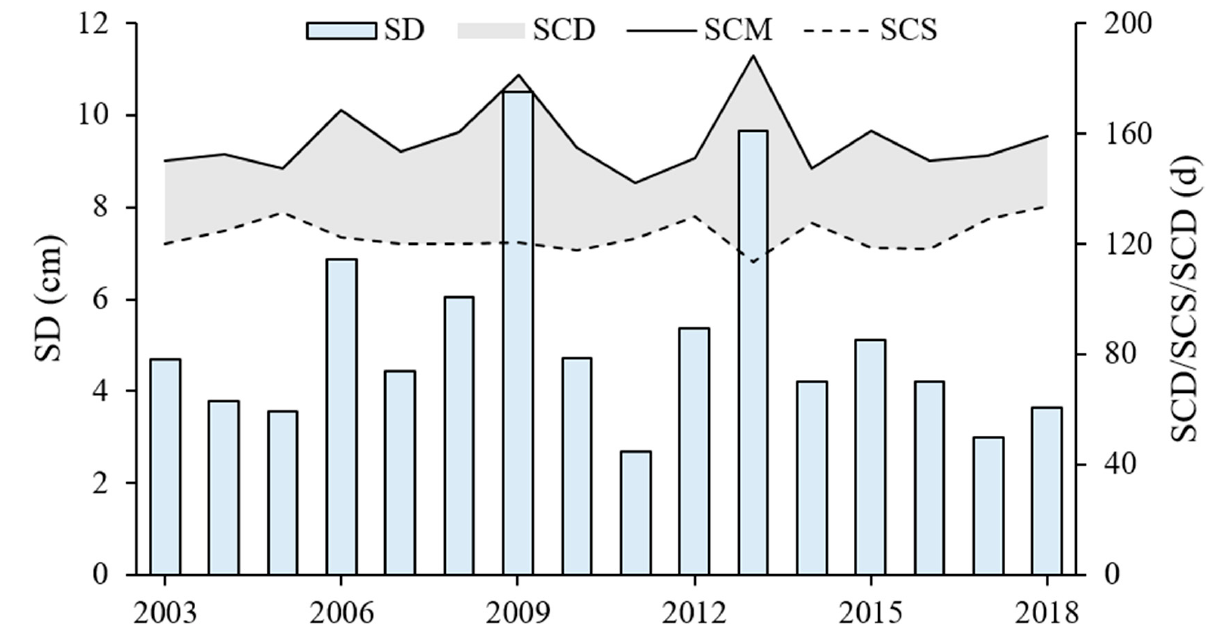
Figure 6. Interannual variations of the four selected LSSP indices on the SGP (2003–2018). The variation trends and amplitudes of the LSSP during the time period from 2003 to 2018 were measured spatially on the SGP based on Sen’s slope method, as shown in Figure 7. A decreasing trend of SD in most of the area occurred, especially in the southwestern part, which is located in the main channel of the Yellow River. A relatively small area had an increase in SD, as in the southeastern part, which dominates the upstream section of the Bailong River. The variation in SD was not significant at p ≥ 0.01 on most of the SGP, especially in the central and northern parts, similar to the significance test for the spatial statistics of the other three LSSP indices. The areal percentage of the reduced SD occupied 60.36%, and the variation amplitude was overall quantified into a rate of − 0.06 cm/a